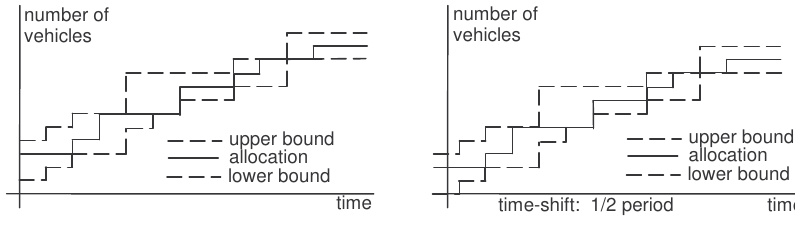
Figure 4. Cumulative requests for vehicle capacity, before and after updating Given the diagram on the left, the diagram on the right is deduced as an updating of the left diagram after half a period ( i.e. ½ * p), assuming that nothing has been changed and the execution has been proceed in conformity with the plan. Graphically this updating is done by shifting the diagram half a period to the left and down over half of the assignment on the first period. In conformity of this setup, each site manager is supposed to send his demand for capacity to the fleet manager in the form of cumulative upper and lower